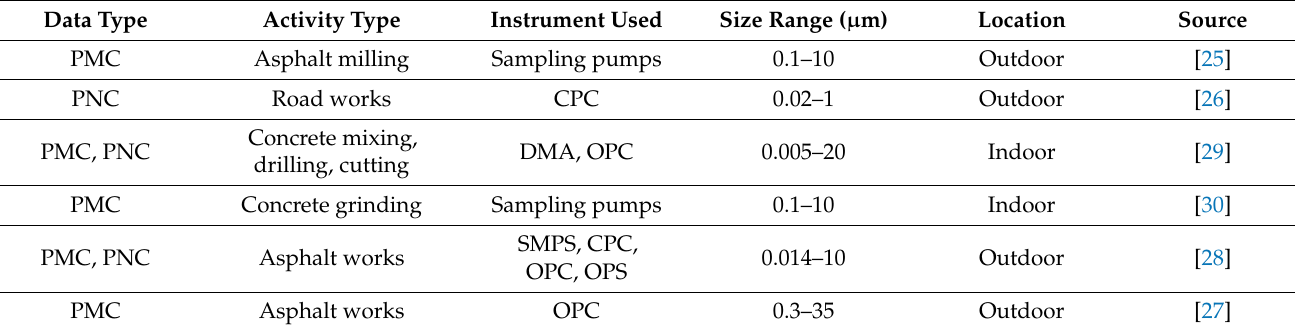
Table 1. Summary of past studies related to PM emissions from road-paving